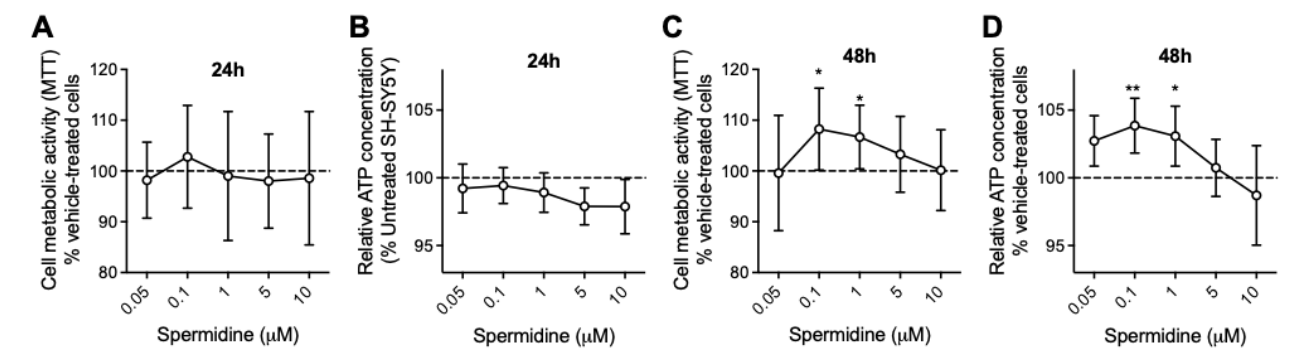
Figure 1. Effects of spermidine on cell metabolic activity and ATP production. ( A ) No effect of spermidine on cell metabolic activity or ( B ) ATP production was observed after 24 h of treatment. ( C ) Spermidine at 0.1 and 1 μ M significantly increased the metabolic activity in SH-SY5Y cells after 48 h of treatment. ( D ) Spermidine at 0.1 and 1 μ M significantly increased ATP production in SH-SY5Y cells after 24 h of treatment. Values represent the mean and SD of four independent experiments (N = 20 – 25 replicates per condition). * p < 0.05; ** p < 0.01; one-way ANOVA and post hoc Dunnett’s multiple comparison test versus control condition (vehicle-treated cells). MTT: MTT assay.